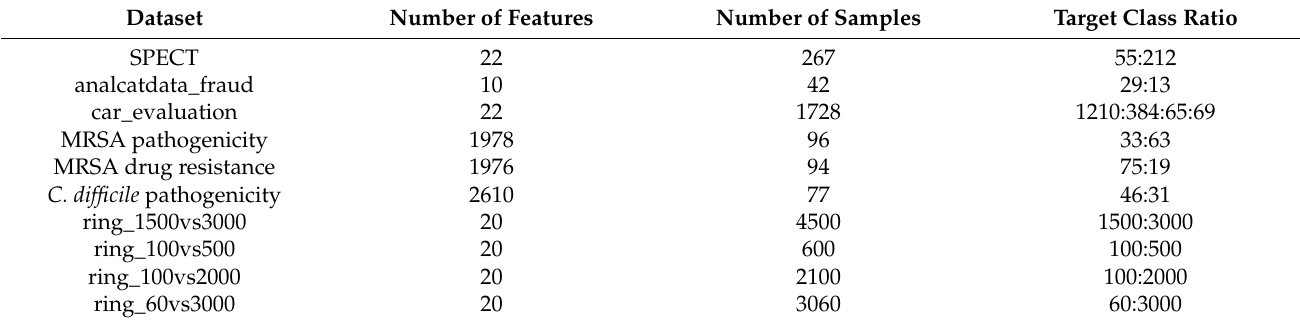
Table 1. Basic information of the dataset used in this